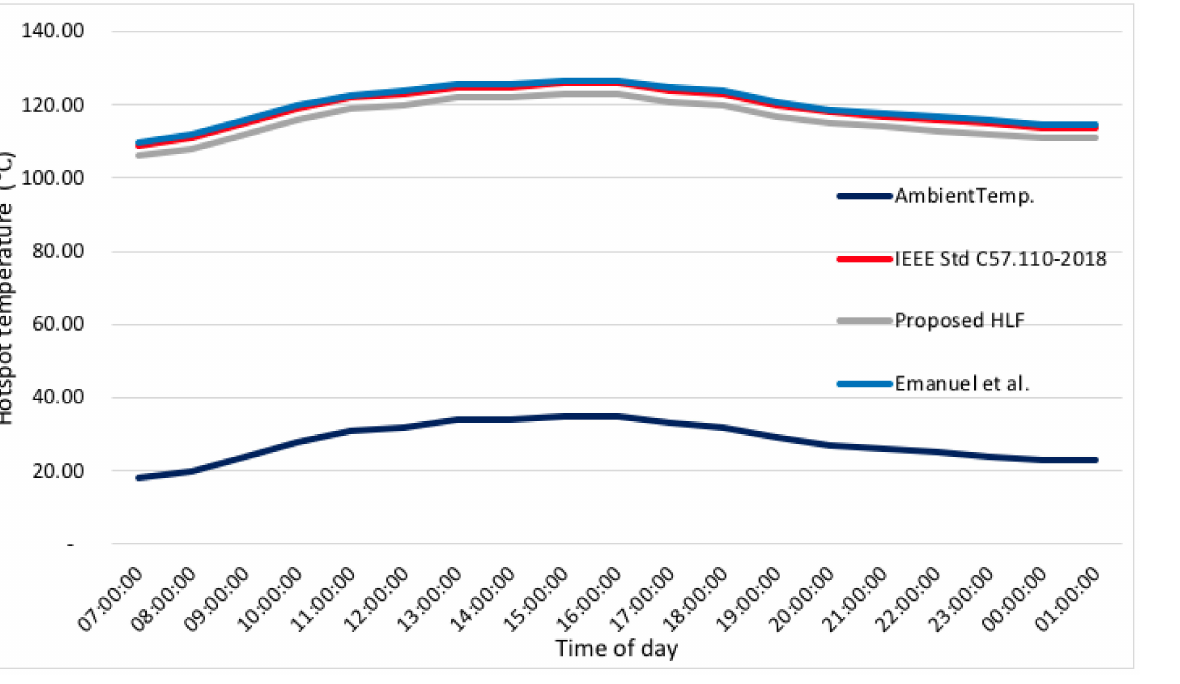
Figure 9. Hourly HST variation, 10 MVA 22/11 kV distribution transformer.